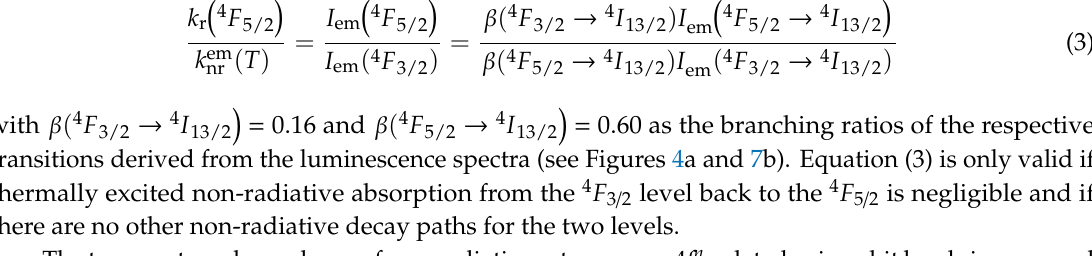
Figure 7. ( a ) Detailed view on the fast decay component from the 4 F 5/2 spin-orbit level of Nd 3+ in microcrystalline La 0.999 Nd 0.001 PO 4 powder. ( b ) High resolution emission spectrum depicting transitions from both the 4 F 5/2 and 4 F 3/2 level into the same 4 I 13/2 ground level acquired upon selected excitation into the 4 F 5/2 level ( λ ex = 808 nm) to separate the contribution of the non-radiative emission from the radiative emission on the decay rate of the 4 F 5/2 level.